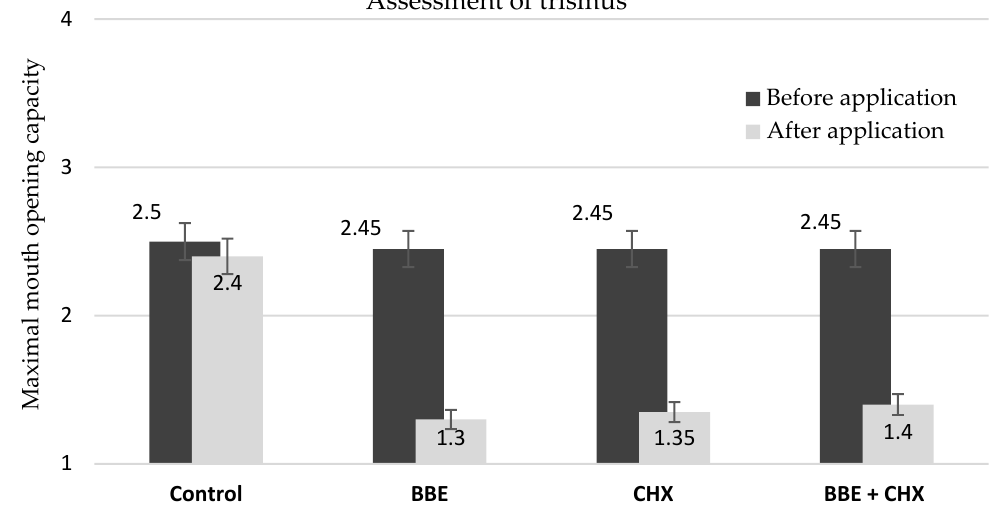
Figure 4. The chart represents the level of trismus assessment before and after the application of tested solutions. Control—patients treated with saline solution; BBE—patients treated with beech bark extract; CHX—patients treated with chlorhexidine; BBE + CHX—patients treated with beech bark extract and chlorhexidine (ratio 1:1).